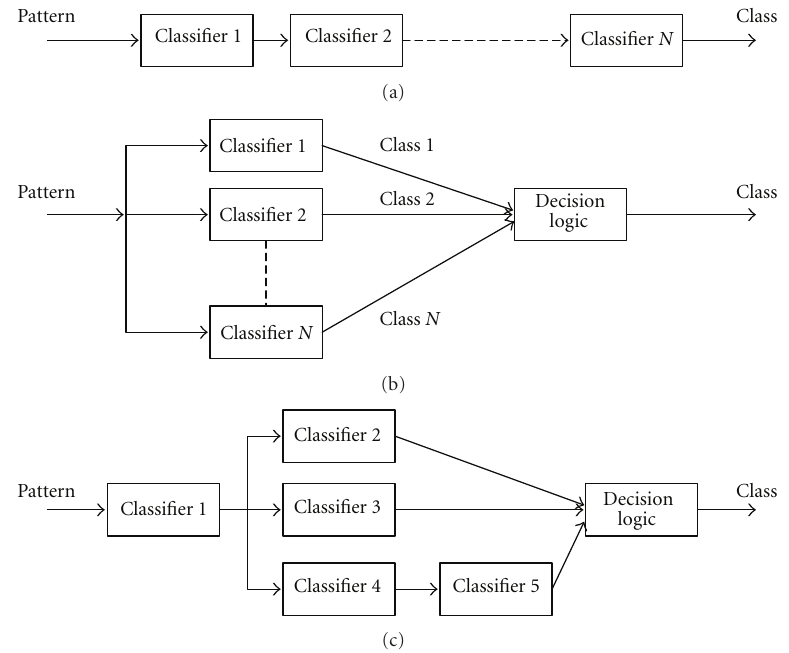
Figure 4: Structures of multiple classifier systems. (a) Cascading, (b) parallel, and (c) hierarchy.